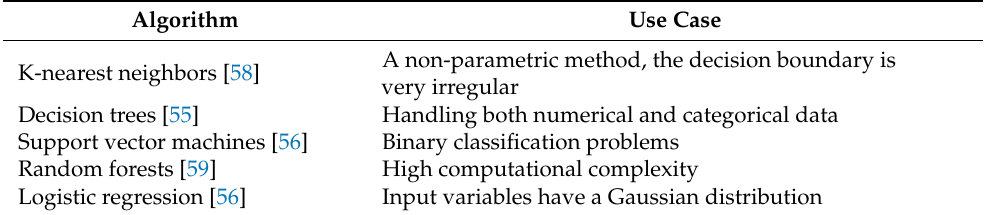
Table 2. Classification algorithms supported by the knowledge discovery engine